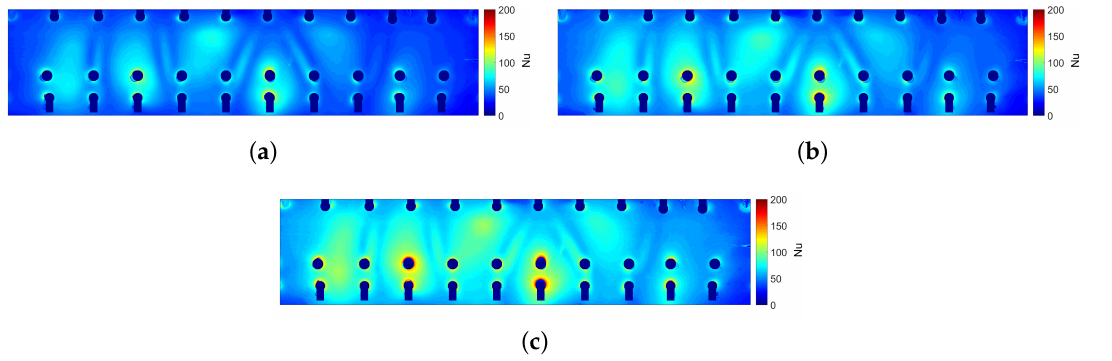
Figure 8. Comparison of measured Nusselt number distributions for geometry 3 with Re = 13,000, 17,500 and 22,000. ( a ) Re = 13,000; ( b ) Re = 17,500; ( c ) Re =